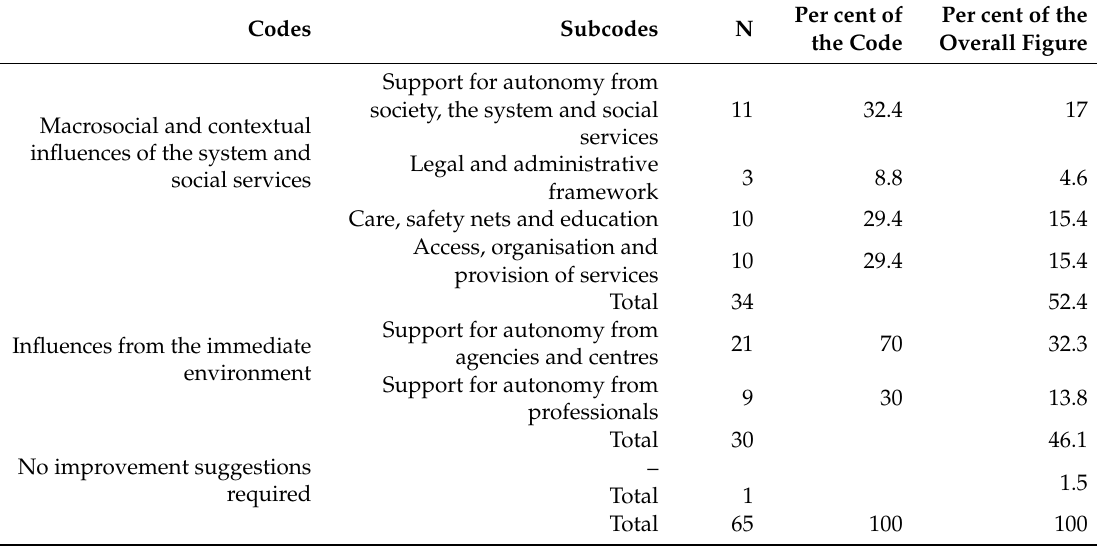
Table 2. Detail of contributions and percentages of suggestions on the management and use of time with young people during their transition to adulthood (frequency of contributions, N).